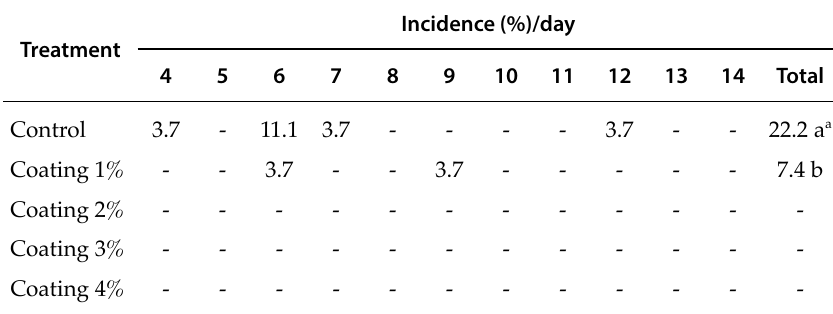
Table 1. Mean proportions of incidence of anthracnose lesions on papaya fruits inoculated with Colletotrichum gloeospori- oides (Control) or coated with different cassava starch concentration gel treatments, during evaluations performed over 11 d